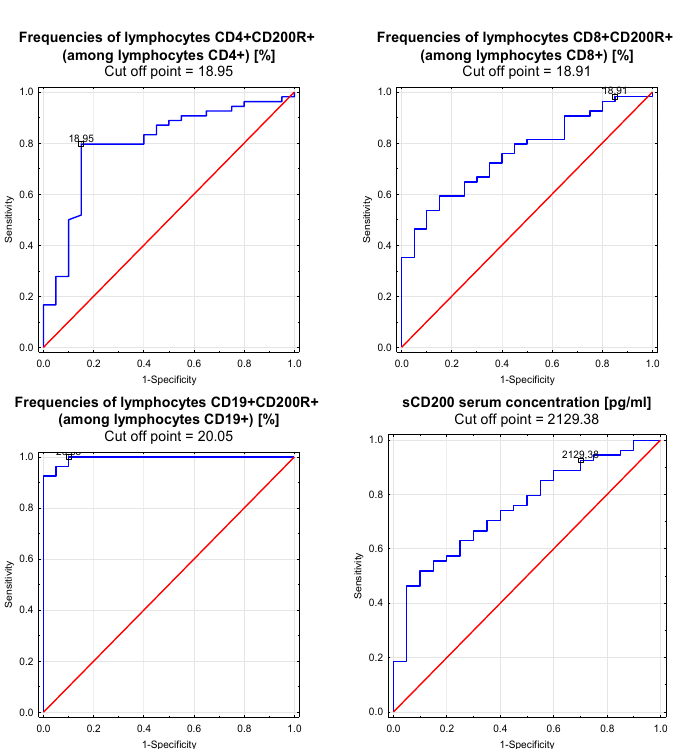
Figure 3. Receiver operating characteristic (ROC) curve analysis showing the sensitivity and specificity of CD200R expression in EMS patients for CD4+/CD8+/CD200R+ T lymphocyte frequencies (%) and CD19+/CD200R lymphocyte frequencies (%).